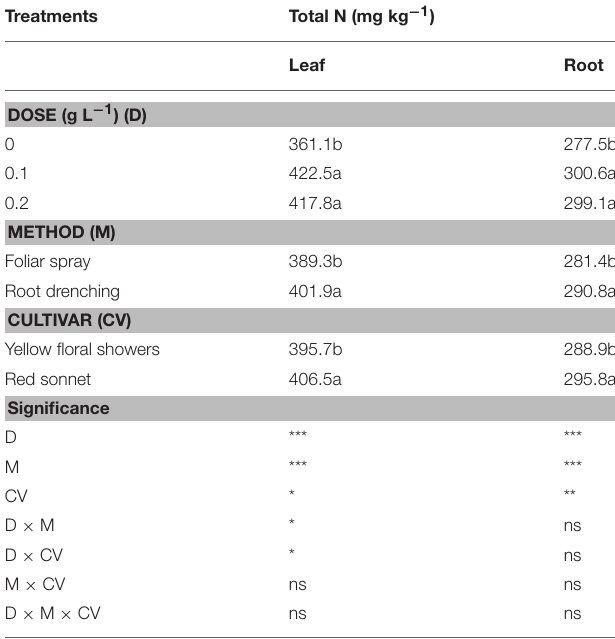
TABLE 6 | Main effects of biostimulant dose, application method and cultivar on leaf and root total N content of snapdragon